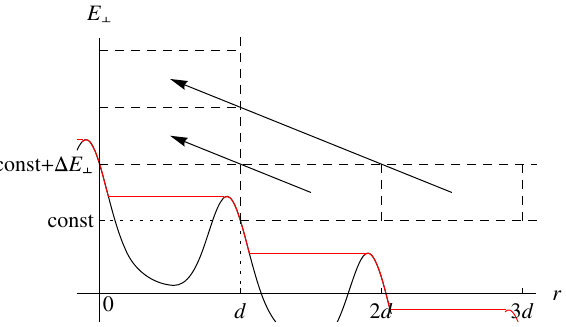
FIG. 10. Red solid curve, lower boundary of the energetically allowed domain for VR in the f r; E ⊥ g plane. Semi-infinite row restricted by the red curve and the horizontal dashed lines — initial integration region for the mean VR angle. Semi-infinite column restricted by the red curve and the vertical dashed lines — the transformed integration region. Arrows show translations of double-full-period cells, not changing the